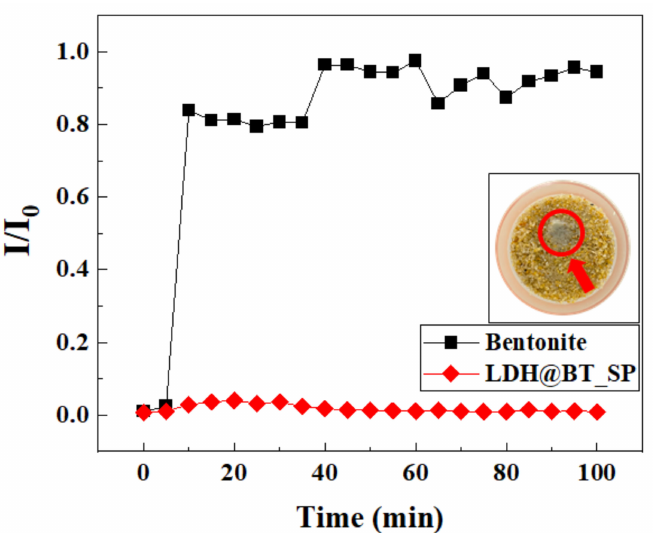
Figure 7. Mobility test in silica sand-filled column results of the pristine bentonite and the LDH– BT_SP under simulated soil conditions (adsorbent concentration = 1 g/L; flow rate = 5.0 mL/min). The inset is a photographic image of the top of the column 100 min after injection with the LDH–BT_SP, where the red arrow and circle indicate the